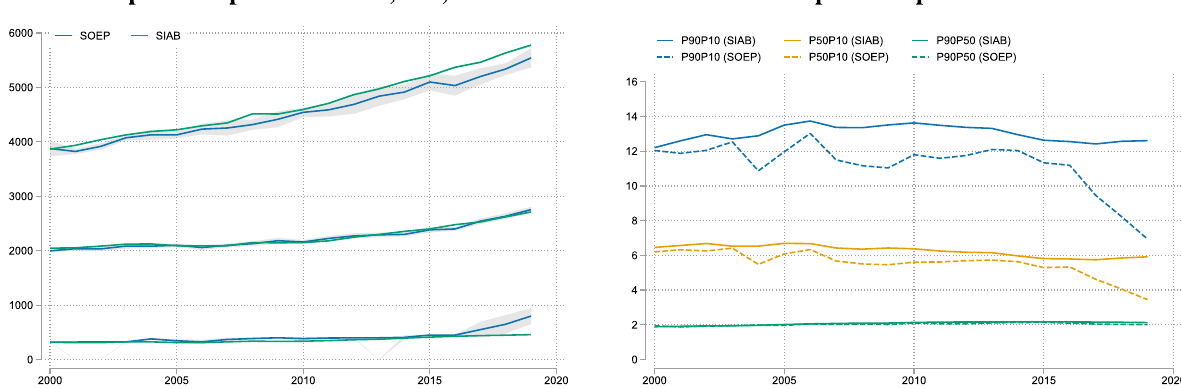
Fig. 3 Monthly wages in 2000–2019; sample: comparable sample; no lower limit. Source: own calculations, SOEP-Core.v37.EU & SIAB 7519. 95% confidence interval indicated by shaded areas (for percentiles only); 500 bootstrap replications